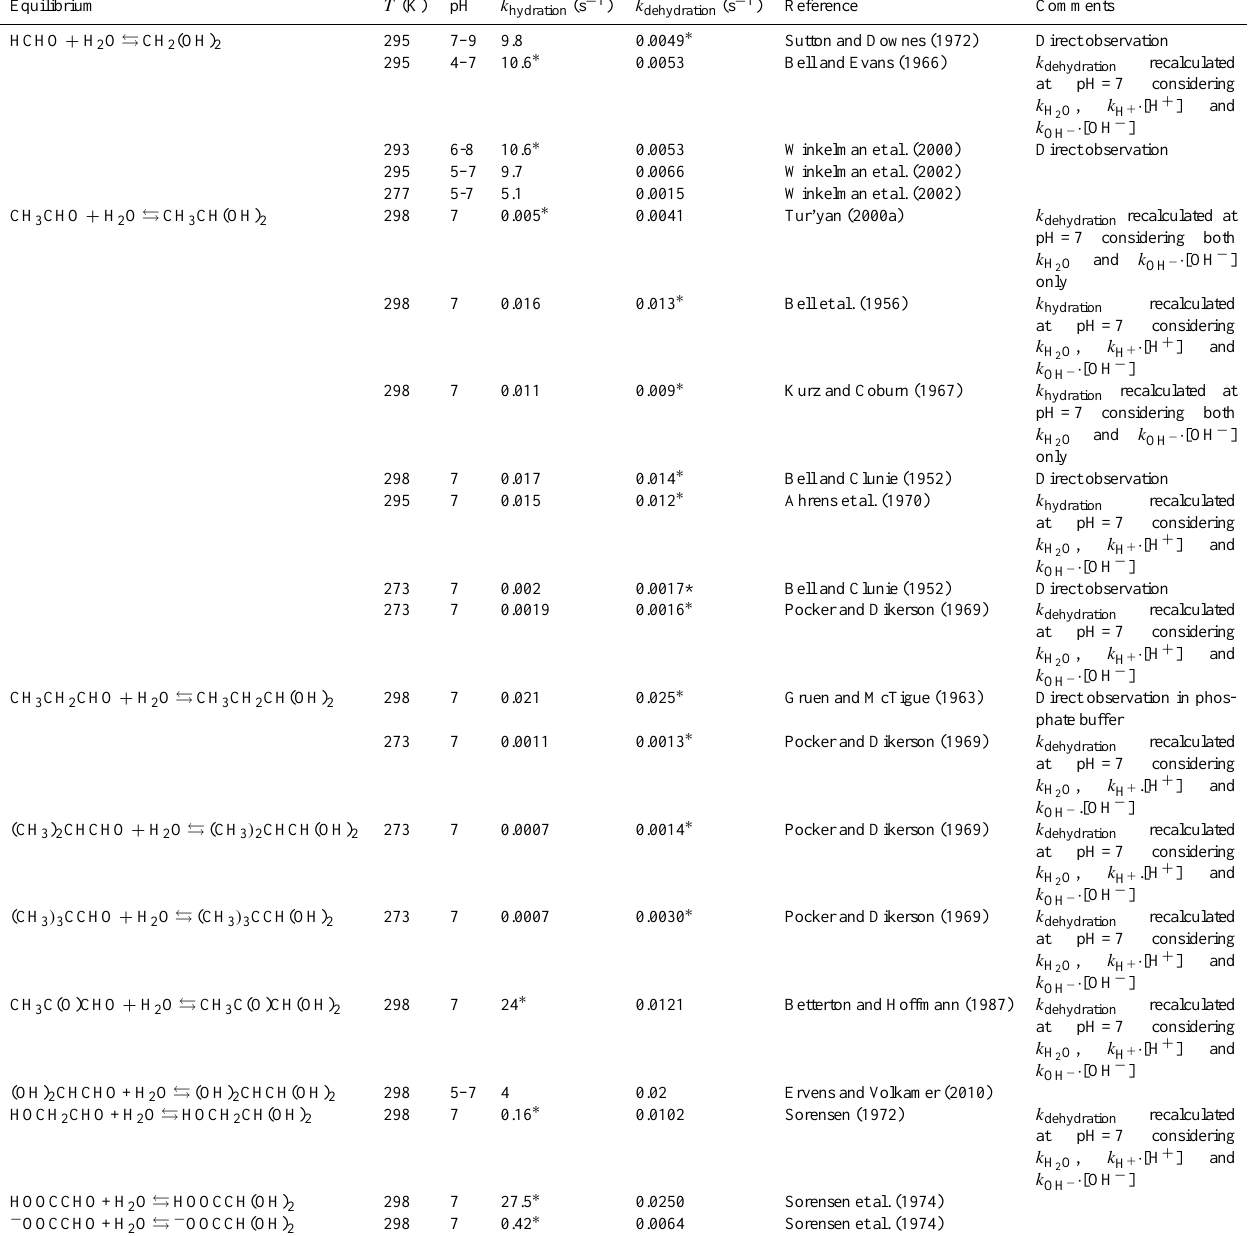
Table 2. Pseudo-first order rate constants and first order rate constants for the hydration/dehydration reactions as reported in the literature